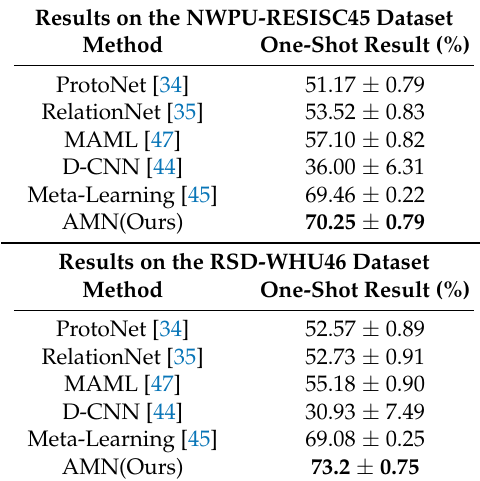
Table 5. Results on two different groups of experiments. The best results on each dataset are marked in